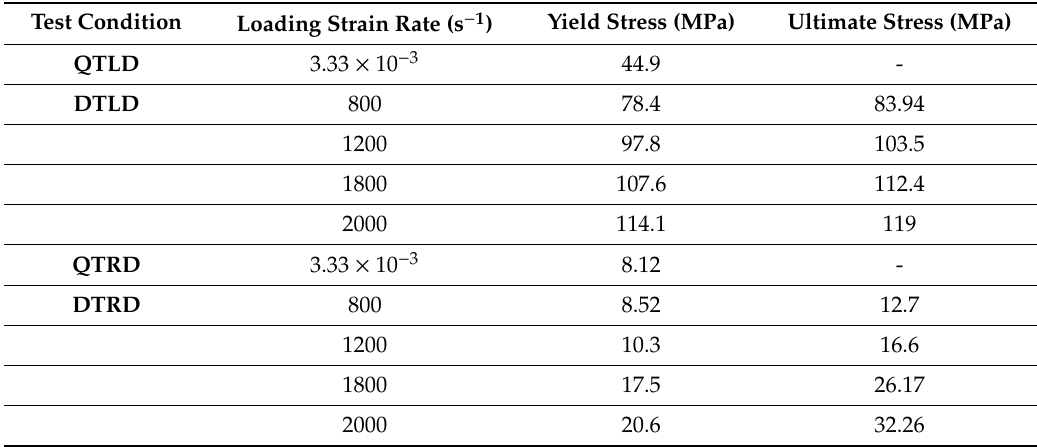
Table 1. Results from quasi-static compressive tests and SHPB compressive tests.